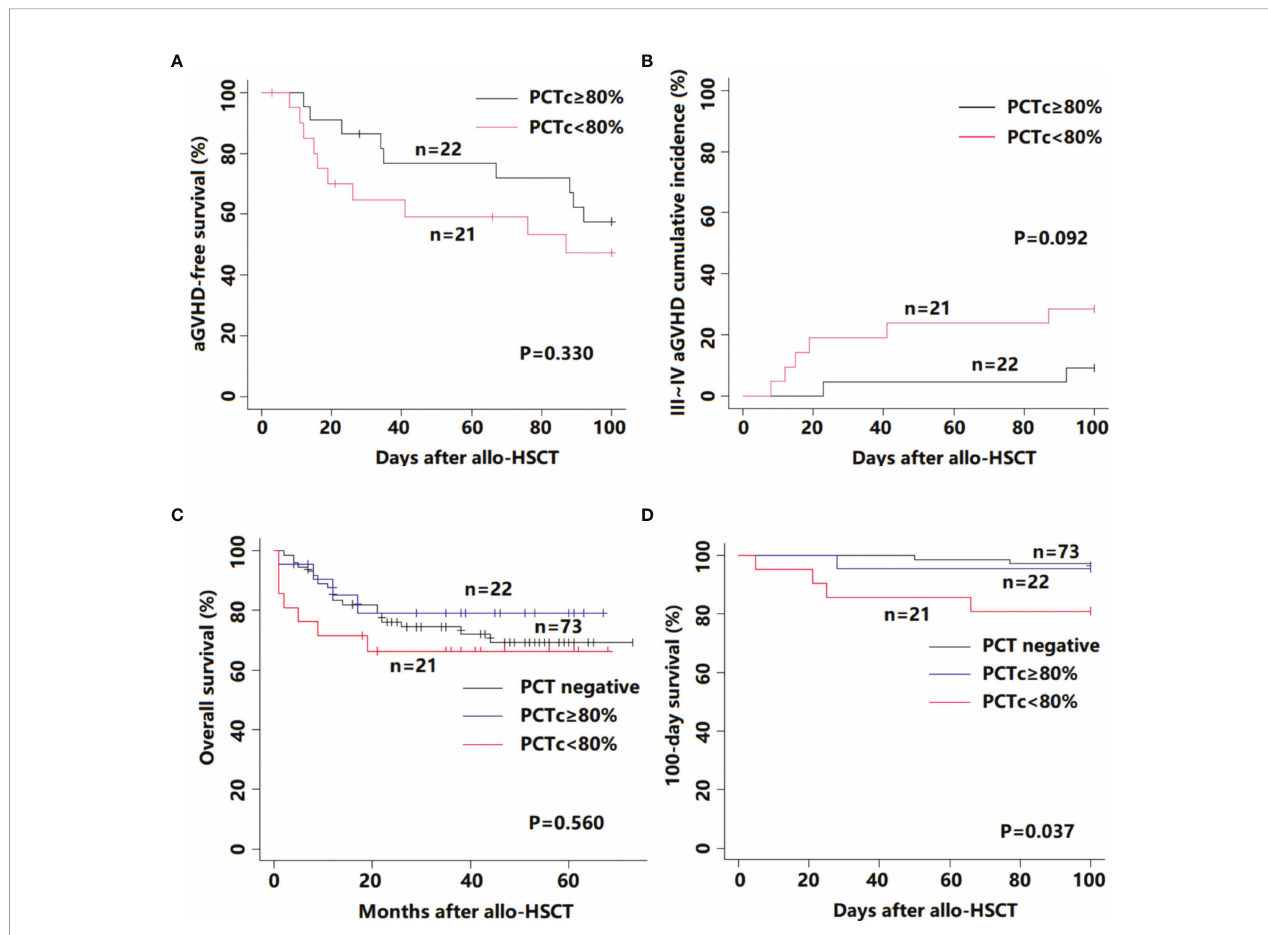
FIGURE 3 | Survival outcome for 116 febrile patients in the neutropenic period after allo-HSCT according to PCTc. (A) aGVHD-free survival; (B) III – IV aGVHD cumulative incidence; (C) overall survival; and (D) 100-day